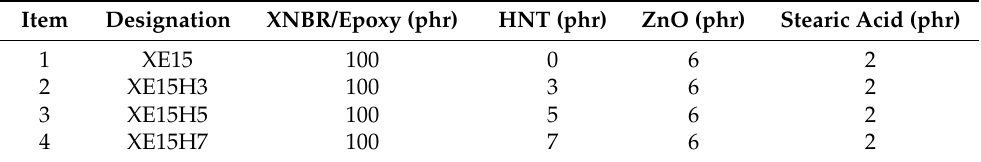
Table 1. Formulations of carboxylated nitrile butadiene rubber (XNBR)/epoxy nanocomposites containing various functionalized halloysite nanotube (XHNT) loadings.